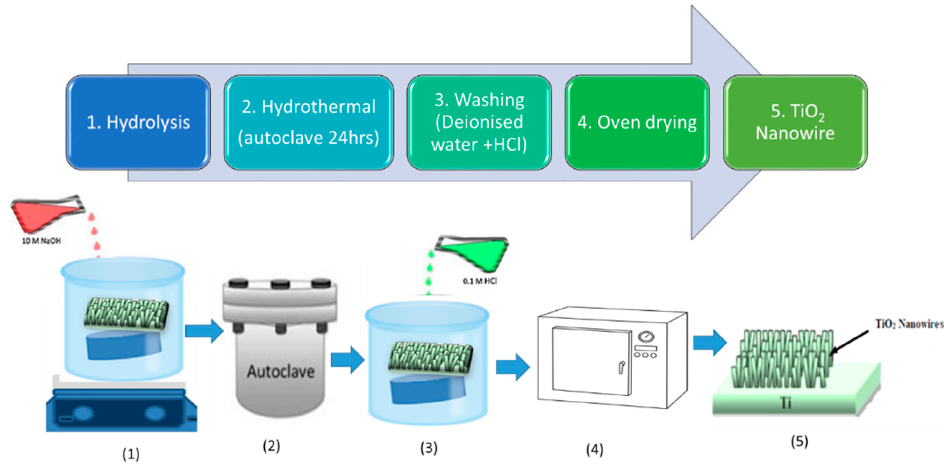
Figure 7. Schematic modification of TiO 2 nanowire using hydrothermal techniques. ( 1 ) Hydrolysis, ( 2 ) Hydrothermal, ( 3 ) Washing, ( 4 ) Oven drying and ( 5 ) TiO 2 nanowire